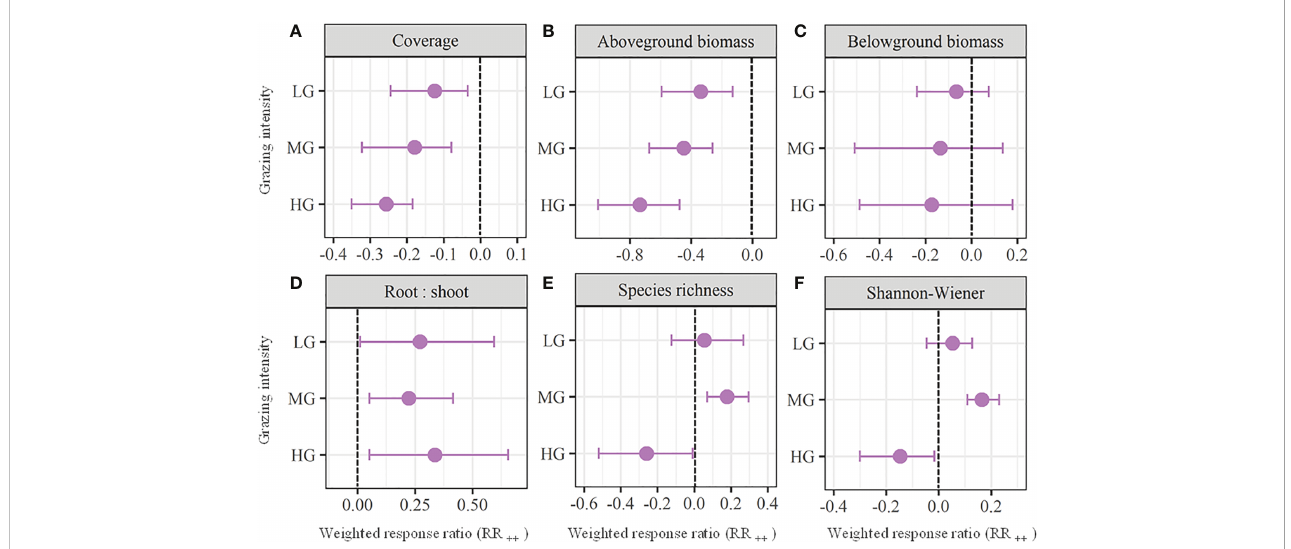
FIGURE 2 Weighted response ratios (RR ++ ) and their 95% con fi dence intervals (CI) for plant characteristics including plant coverage (A) , aboveground biomass (B) , belowground biomass (C) , root: shoot (D) , species richness (E) , and Shannon-Wiener index (F) in the lightly (LD), moderately (MD), and heavily (HG) grazing alpine grasslands. The overall effect sizes are unitless grand means from weighted meta-analyses. The dots with error bars indicate the mean effect size with the 95% CI. The observed effect sizes were considered statistically signi fi cant if the 95% CI did not include